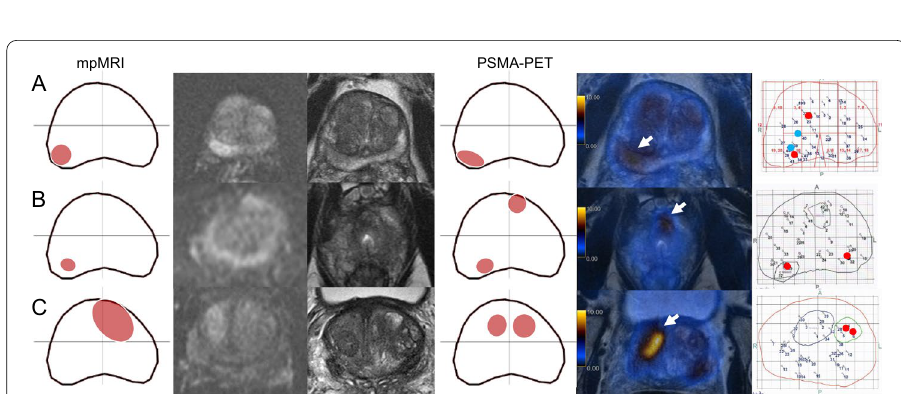
Fig. 5 Imaging and histopathological findings of cases in which imaging findings of both mpMRI and PSMA PET were false-positive or false-negative using template biopsy as reference standard. Each line corresponds to one patient. From left to right: mpMRI readout, DWI, T2-w, PSMA PET/MRI readout, fusion PSMA PET/MRI and template biopsy map. A Both imaging modalities depicted the lesion in the posterior right quadrant (arrows) but missed the lesion in the anterior right one (Pat. 7). B Both imaging modalities depicted the lesion in the posterior right quadrant (not shown) but missed the left one and PSMA PET was also false-positive for the anterior left quadrant (arrow). C Imaging was false-positive in the anterior right quadrant, on mpMRI the lesion seems to cross the midline while in PSMA PET the uptake suggests a second lesion